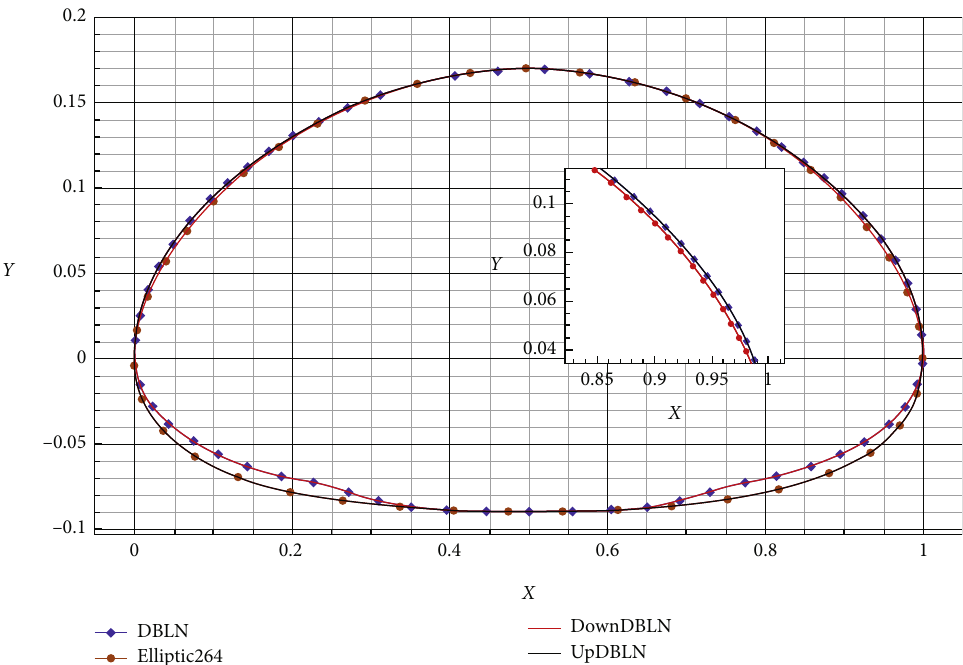
Figure 12: Pro fi les of airfoil section used in the present